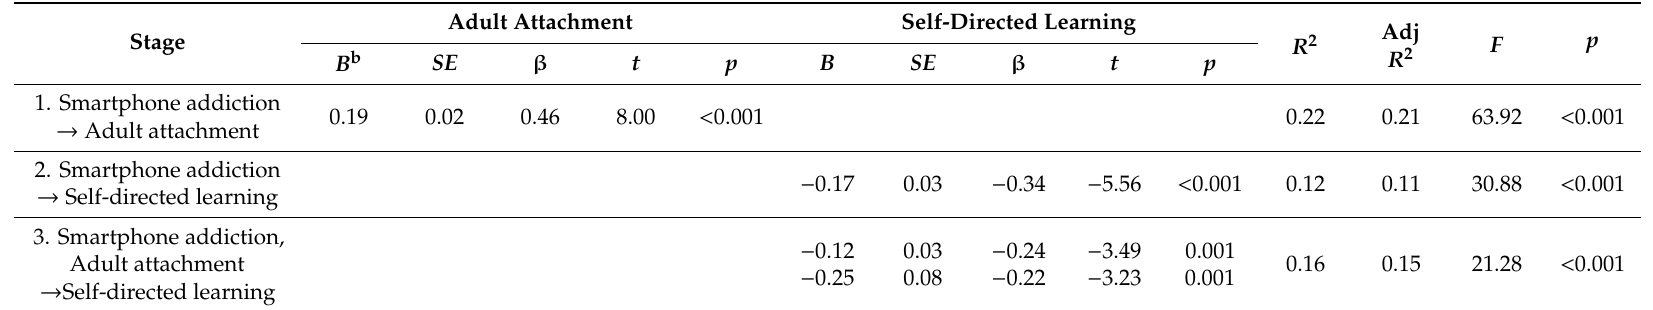
Table 3. The mediating e ff ect of adult attachment on the relationship between smartphone addiction and self-directed learning ( n = 235).